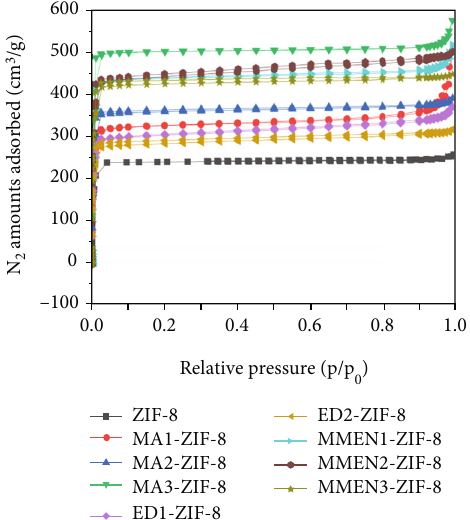
Figure 2: N adsorption-desorption isotherms of modi fi ed ZIF-8 2 samples at 77